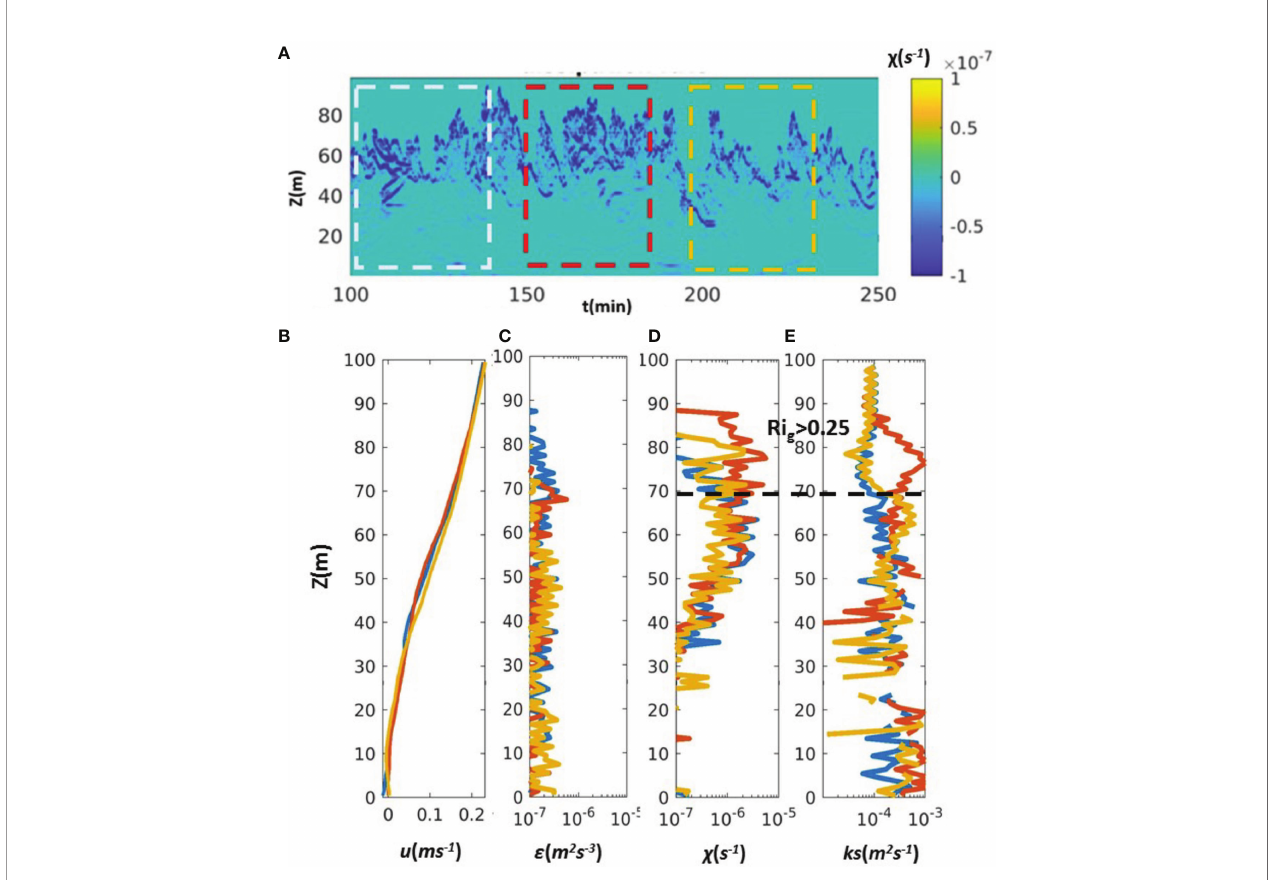
FIGURE 10 | Model results of Case A: the time series of (A) density variance dissipation. The blue, red, and orange lines indicate the interval for 30 minutes time average. (B) The time average pro fi les of fl ow shear, (C) TKE dissipation rate, (D) density variance dissipation, and (E) eddy diffusivity at location x =800 m (see Figure 4 for the